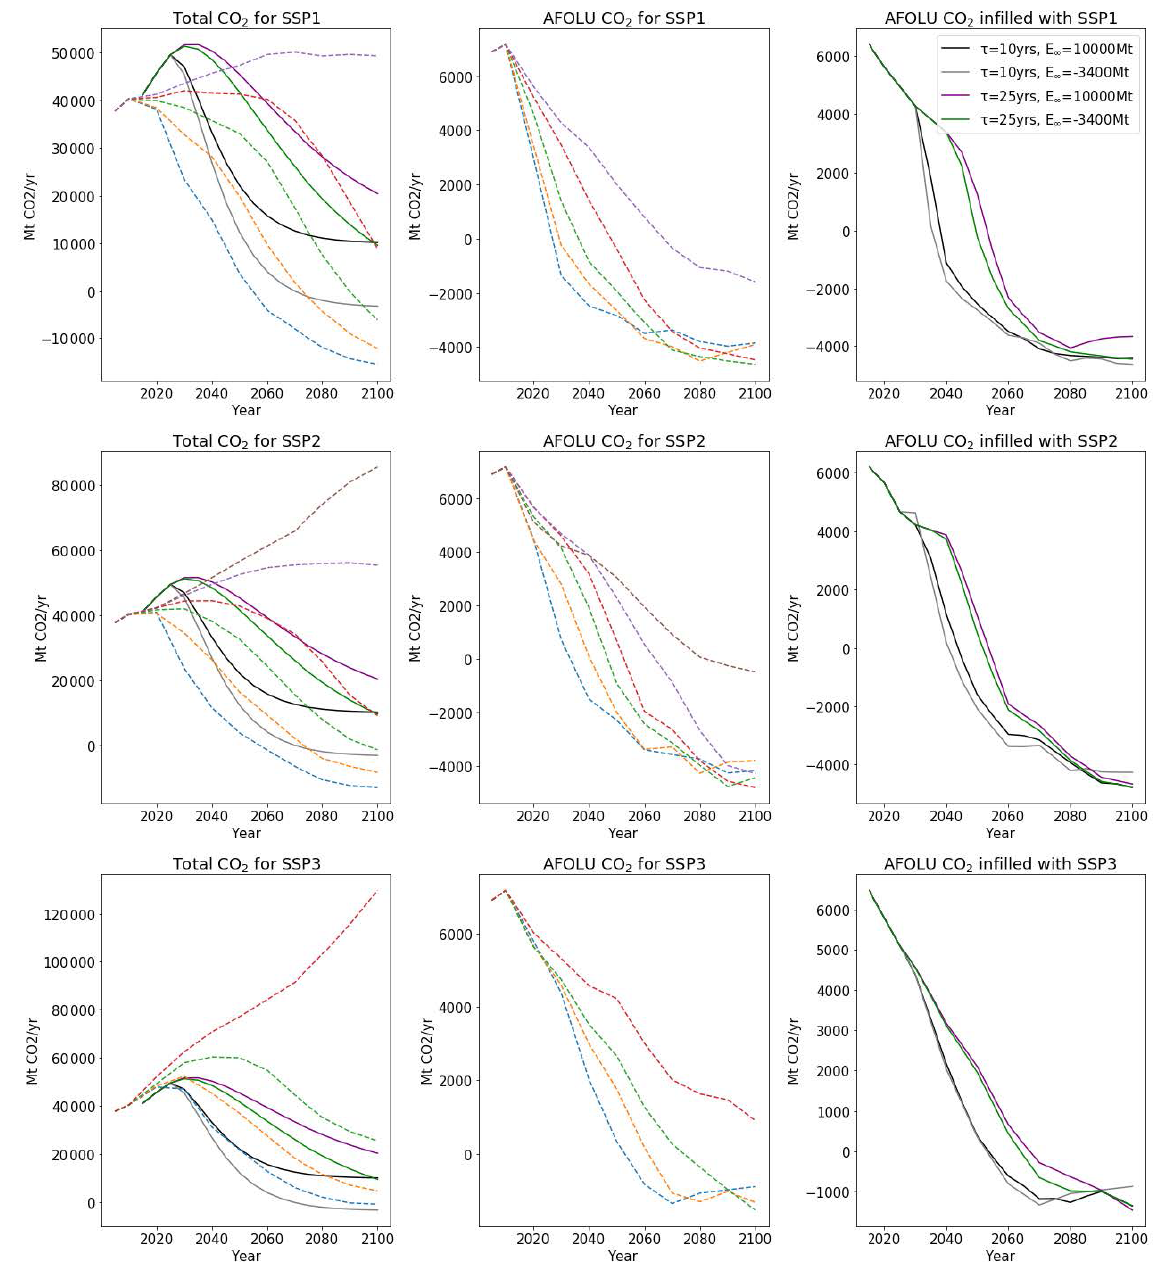
Figure 7. Illustration of using the “interpolate specified scenario” cruncher to infill a series of stylised trajectories (solid lines) characterised by two different parameters ( τ and E ∞ ), as defined in (Sanderson et al., 2016). The first column compares the total CO 2 calculated for the stylised trajectories to the values of the MESSAGE model for a given group of SSP scenarios (dotted lines). These are our lead values in each case. The second column shows the range of follower values for that SSP. The third column shows the resultant AFOLU (agriculture, forestry, and other land use) trajectories that emerge from using the “interpolate specified scenario” infiller.